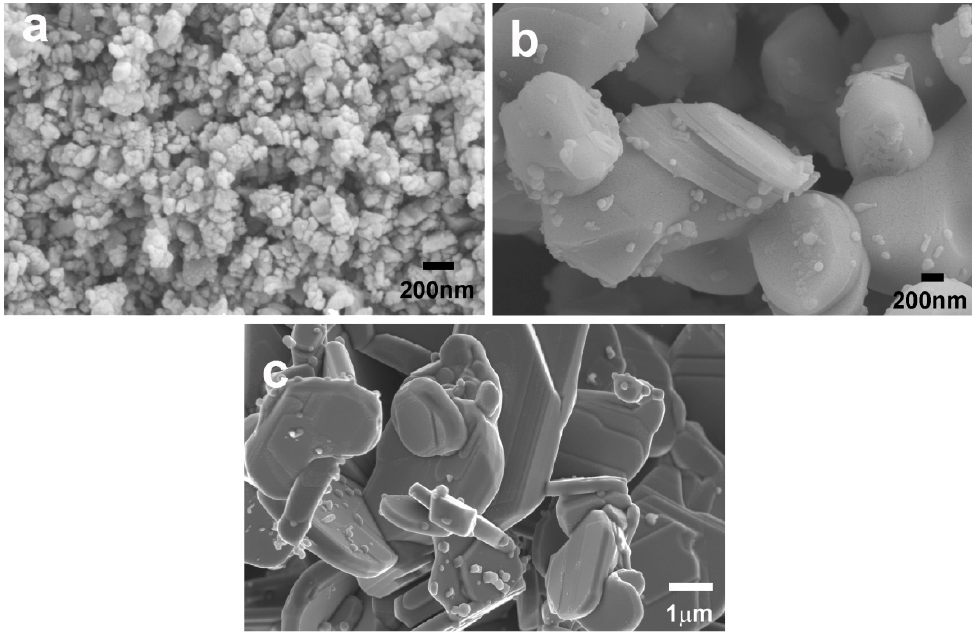
Figure 3. Representative FESEM micrographs obtained on ( a ) as-milled attrition powders; ( b ) attrition-milled powders after calcination at 850 °C for 1 h; ( c ) ball-milled powders after calcination at 750 °C for 12 h + 800 °C for 12